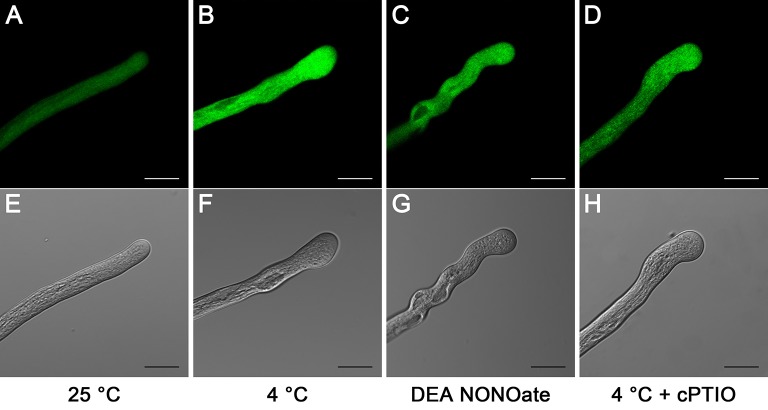
Effects of cold stress or DEA NONOate on cytoplasmic ROS in C. sinensis pollen tubes. In the control pollen tubes, the ROS fluorescence signal was symmetrical and weak and was distributed throughout almost the entire pollen tube (A). After treatment with cold stress (B) or 25 μM DEA NONOate (C) for 1 h, the ROS fluorescence signal significantly increased, particularly in the tip region. The increase in the ROS fluorescence signal stimulated by cold stress was largely reduced after treatment with 200 μM cPTIO (D). The corresponding bright field images are shown below (E–H). At least 20 pollen tubes were observed and photographed in each of three replicates, and one representative image per treatment was displayed. Bar = 20 μm.